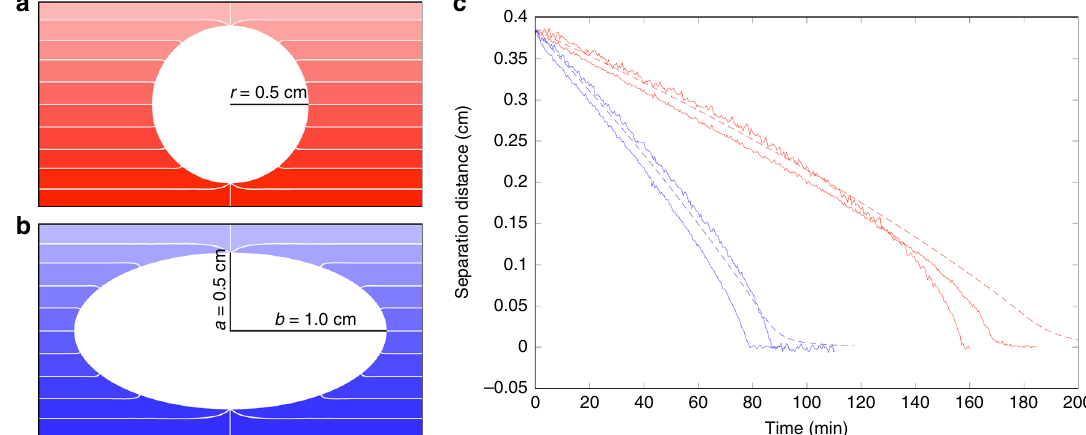
Fig. 2 Experiments and computations with large sphere/spheroid. a , b Side view geometries, and numerically computed density isolines, Pe ¼ 41, sphere radius, 0 : 5 cm, spheroid width, 2 cm, density increments ~0 : 001 g cc − 1 , with density gradient σ ¼ 0 : 007 g cm − 4 . c Experimental and computational evolution of separation distance as a function of time between a large sphere and a small passive sphere and between a large spheroid and a small passive sphere. All experimental trajectories are plotted with the same initial separation. Also shown are the companion trackings produced by our computational simulation for the two geometries (dashed lines). The diffusion-induced fl ows generated by either large body advect and attract the small passive particle until contact. Note that the velocities in the case of the oblate spheroid are larger than the case of the